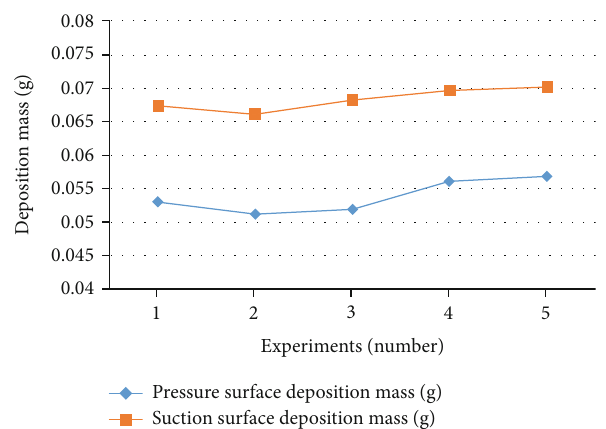
Figure 7: Comparison of the scale qualities of the blade surface areas.